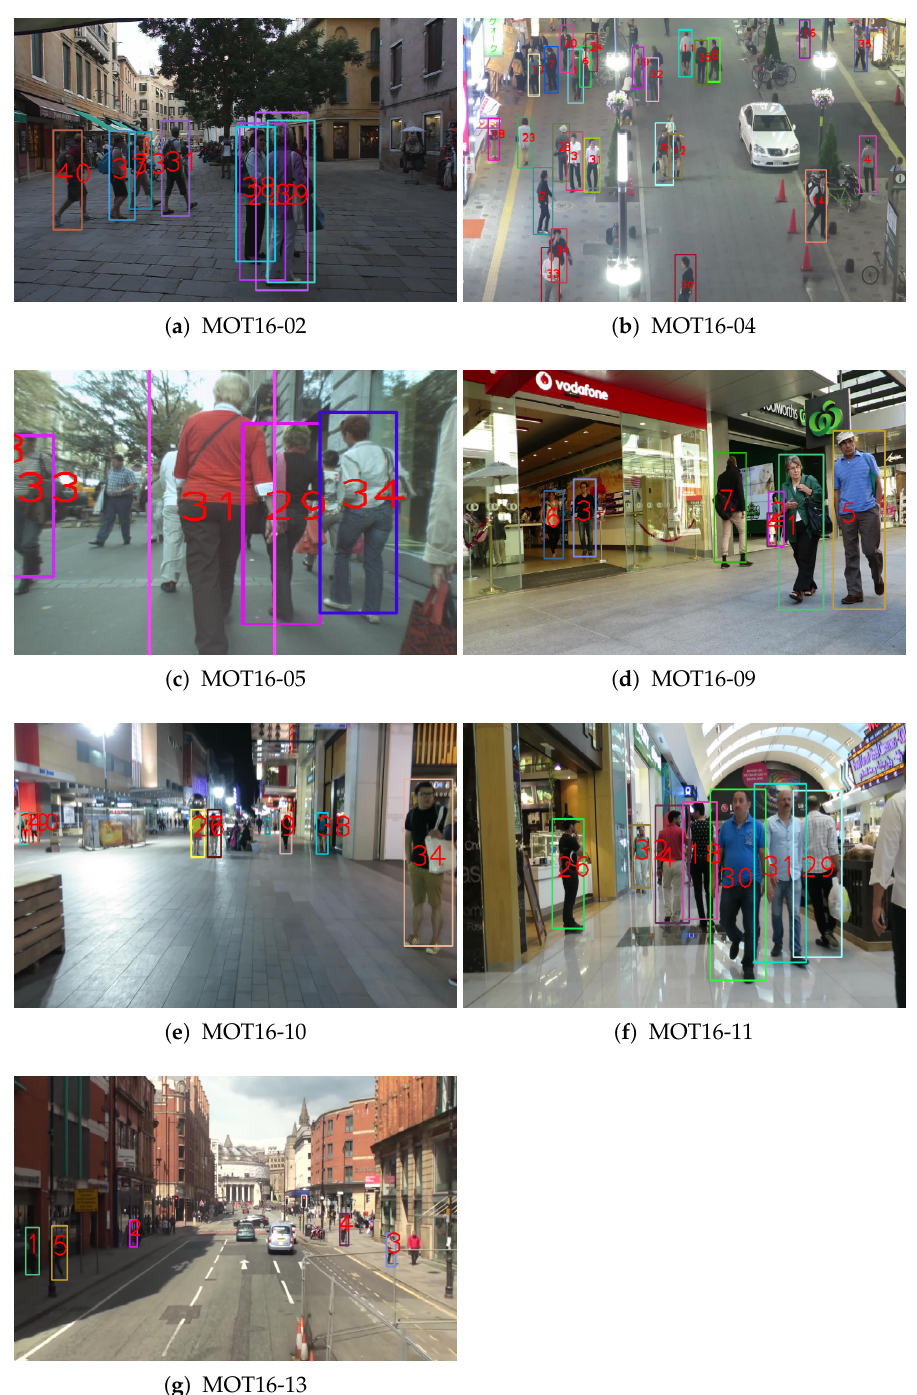
Figure 8. ( a – g ) Tracking results using the proposed MOT method with global appearance and motion models on the 2016 MOT benchmark train